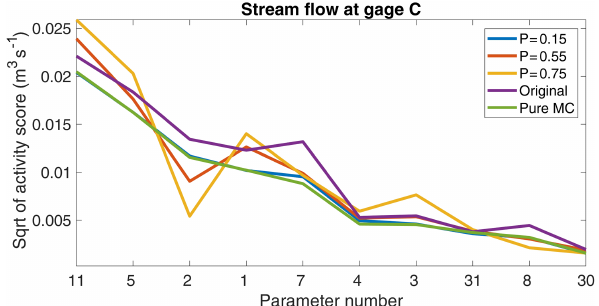
Figure 5. Square root of activity scores of the 10 most influential parameters for the target variable stream flow at gage C resulting from applying the active-subspace-based global sensitivity analysis to the posterior distributions using the different sampling